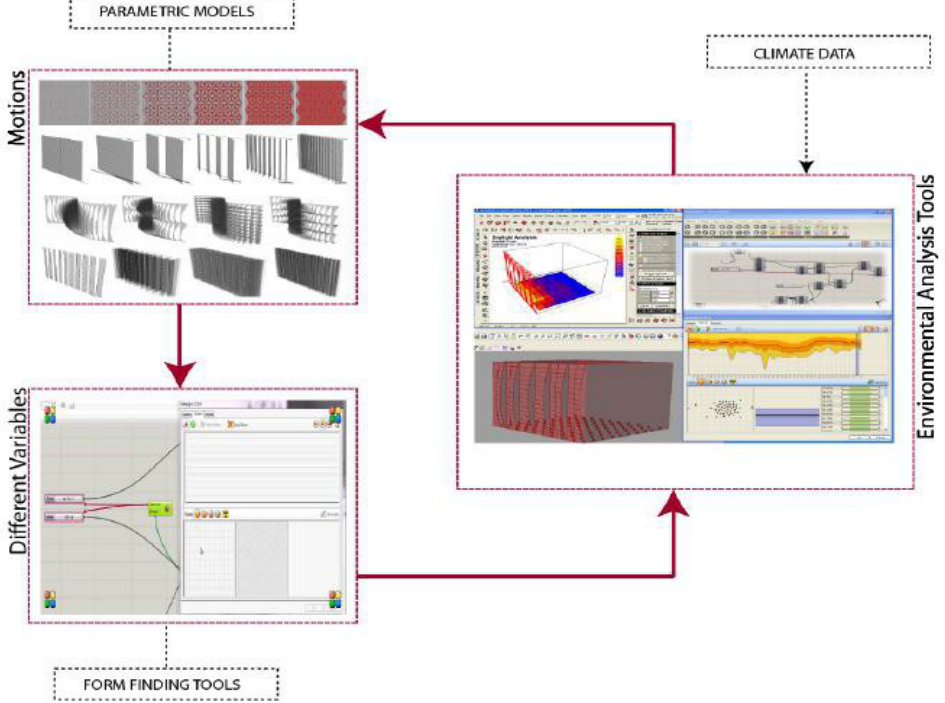
Figure 5. Explains the process of these simulations to find the optimal facades configuration. The variables were represented by sliders with set minimum and maximum values dep ending on designers‟ requirements (Cheung,